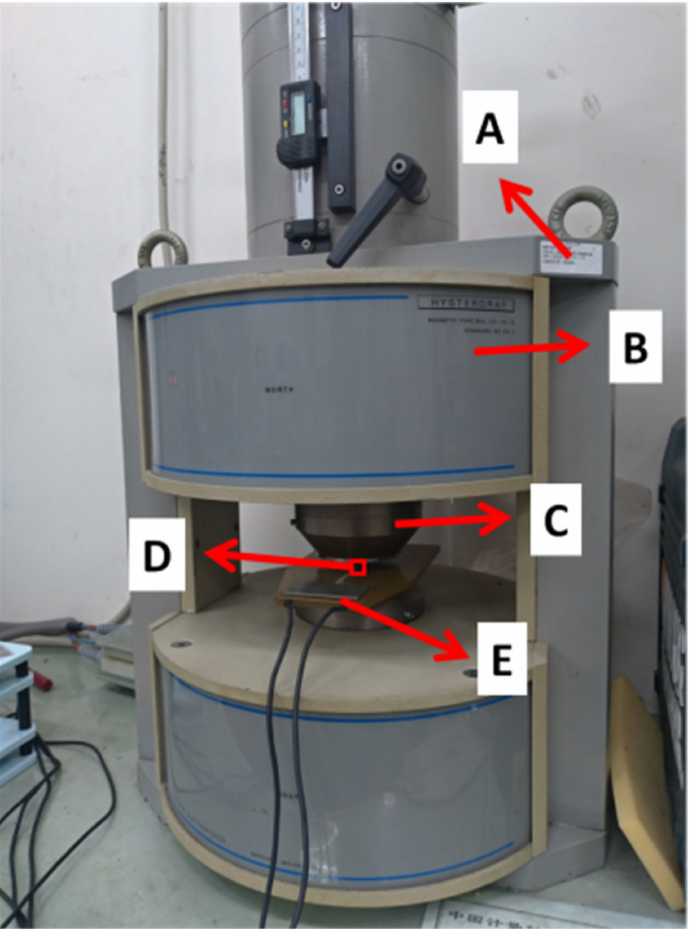
Figure 5. Experimental setup. Item “A” is the B-H tracer, item “B” is the magnetizing coil, item “C” is the magnet holder, item “D” is the magnet to be measured, and item “E” is the pickup secondary